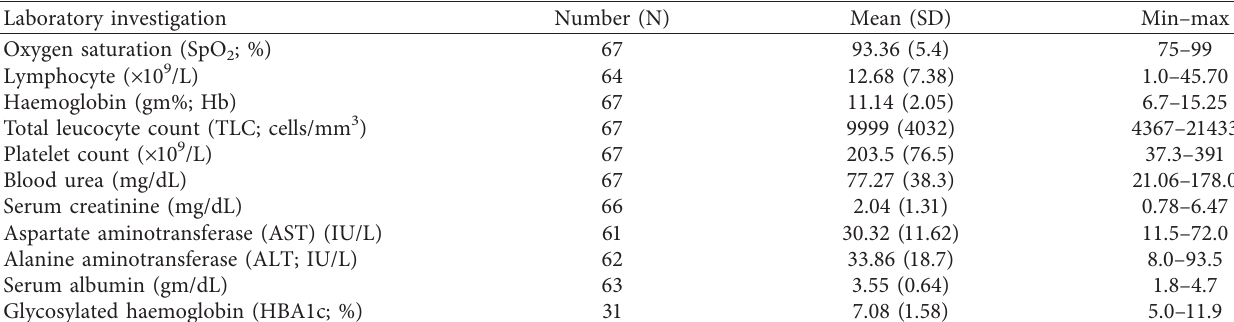
Table 2: Laboratory investigations in kidney transplant recipients with